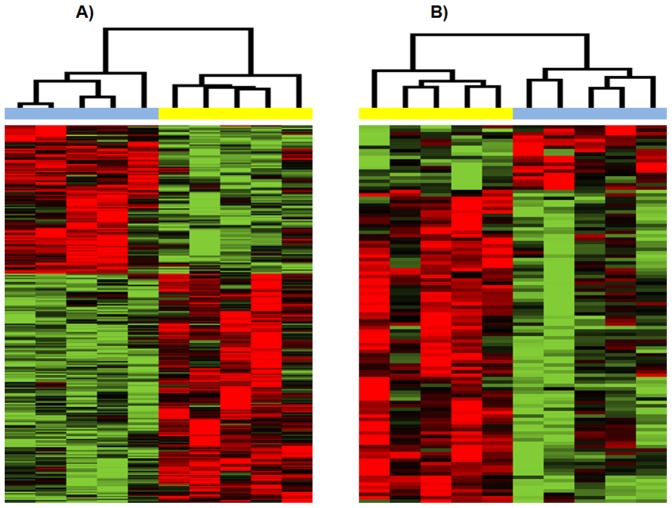
Hierarchical clustering of patient samples based on differentially
expressed genes (P<0.01) obtained from comparing late stage versus
early stage in the USC group and EAC group, respectively.
A) USC group. B) EAC group. In
clustering dendrogram, blue stands for early stage samples while yellow
stands for late stage samples. Red means up-regulated while green means
down regulated.